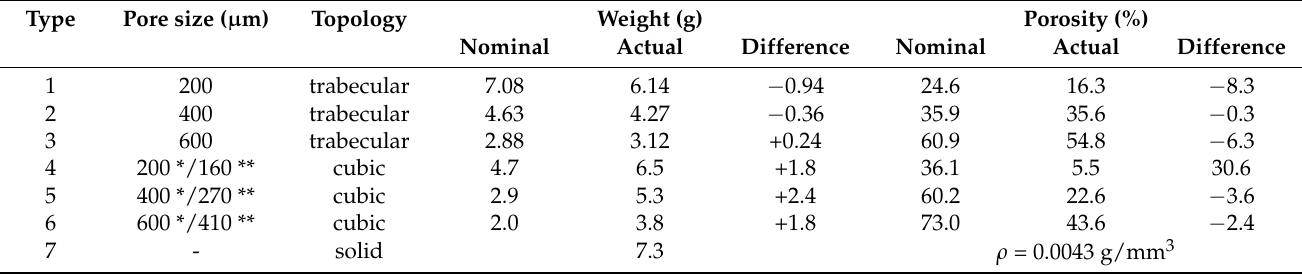
Table 5. Comparison of nominal and actual weight and porosity of the prepared